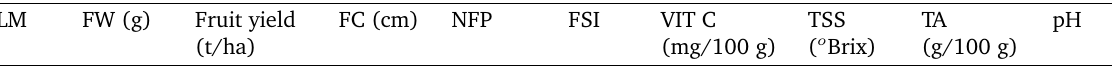
Table 5. Pearson’s correlation coefficient (r) of agronomic, nutritional and physicochemical traits of wild tomato accessions evaluated under a rainforest agro-ecology in Nigeria